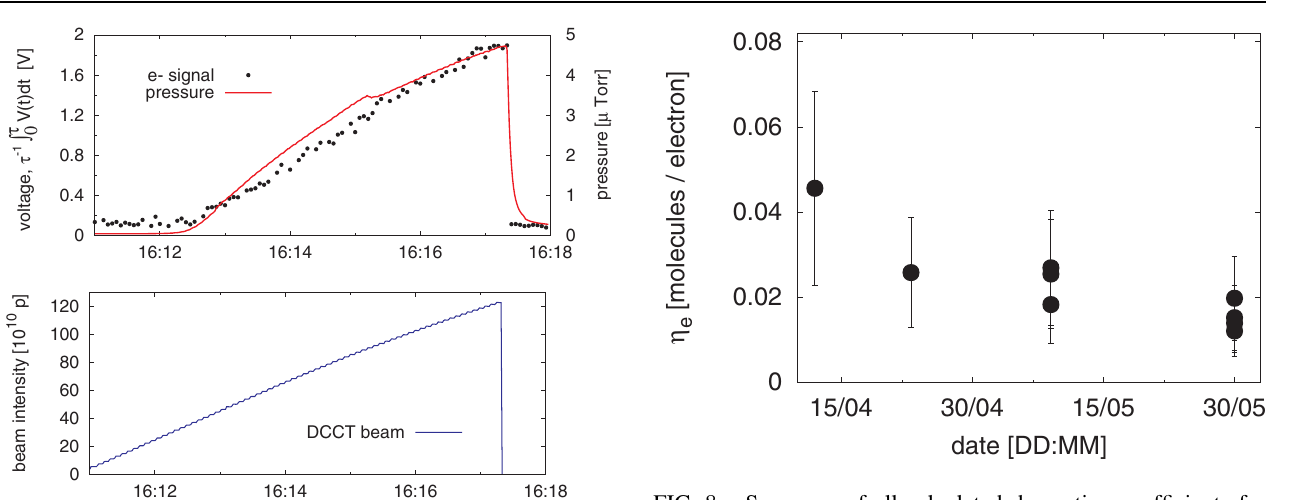
line shows the result of a linear regression applied to the red points,